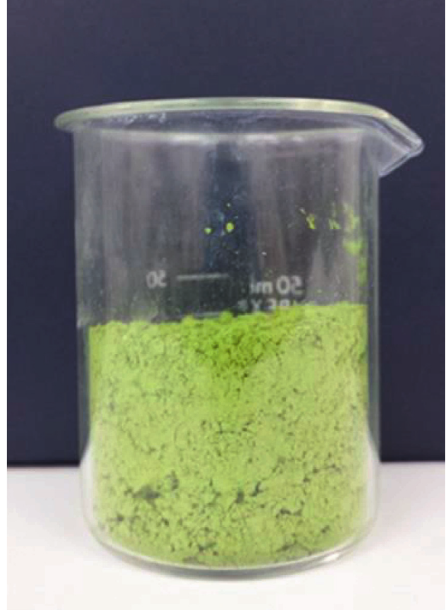
Figure 3: Picture of dry food powder (in